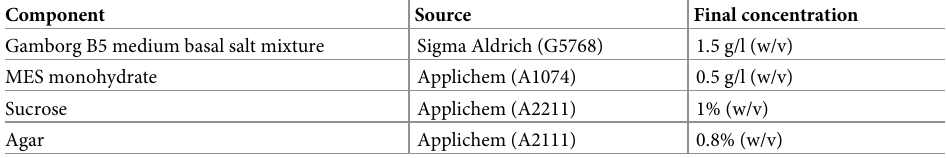
Table 2. Components of ½ Gamborg